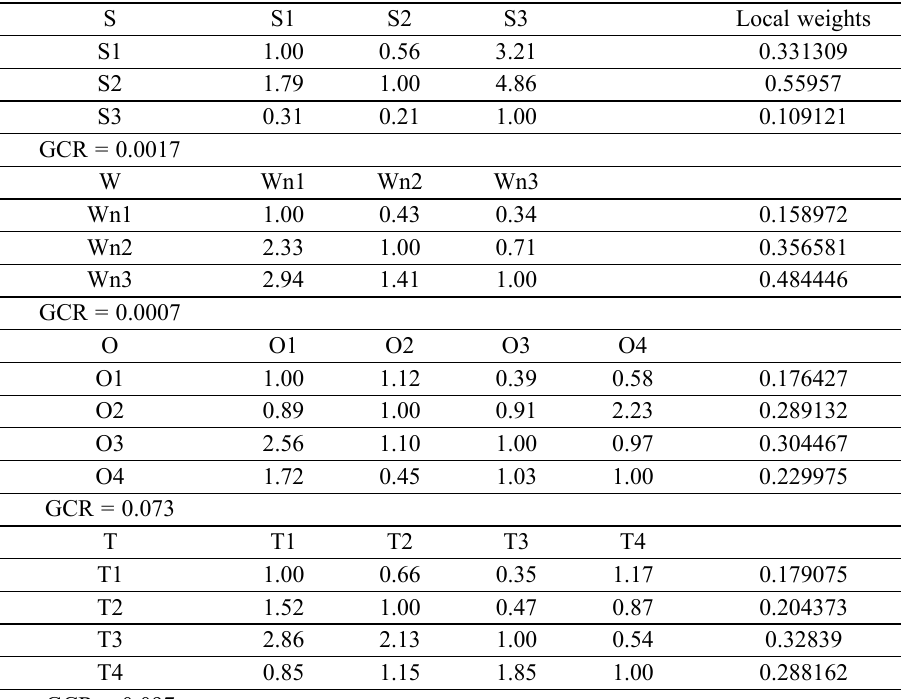
Table 8. Pairwise comparison matrices for SWOT sub-factors local